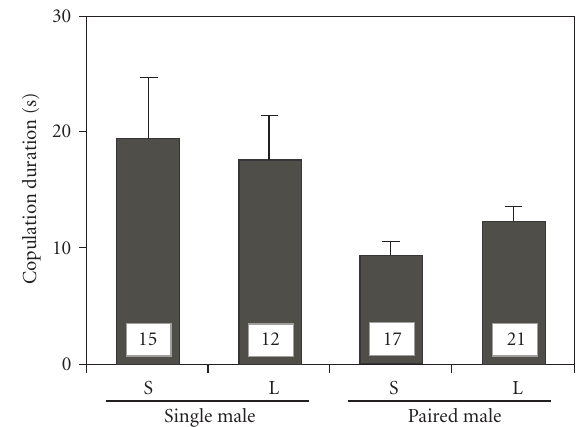
Figure 2: (Mean ± SE) copulation duration for each treatment. Sample size of the observed copulations is shown at the base of each bar.